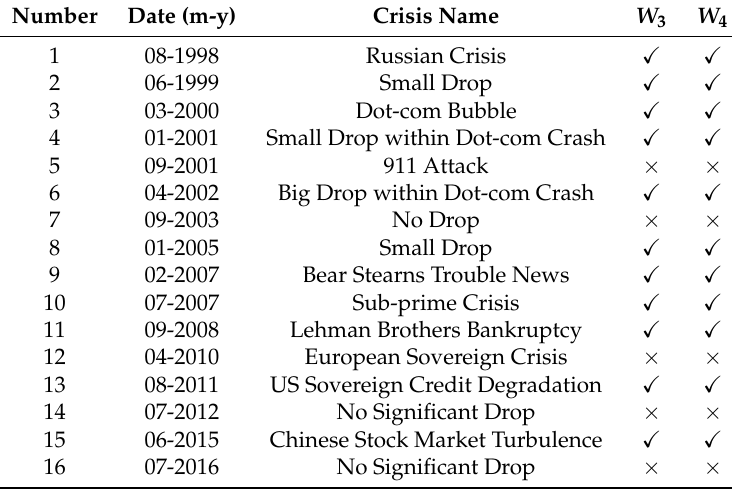
Figure 15. Square Wave W 4 of Systemic Risk Indicator I 4 a . Table 3. Financial Drops vs. Adjusted